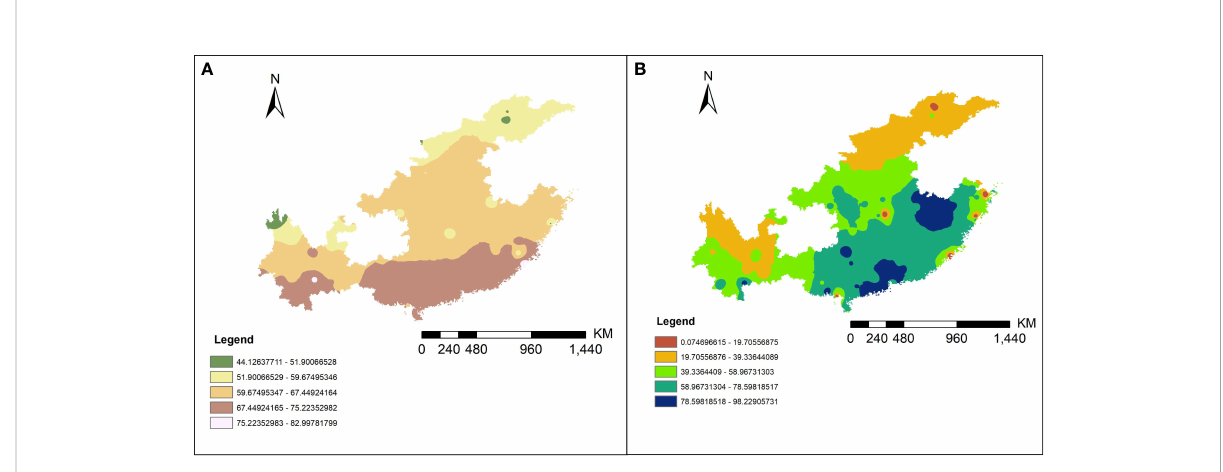
FIGURE 4 The predictive results map of the AAT (A) and AAR (B) in 11 provinces of China from 2011 to 2020 by IDW interpolation